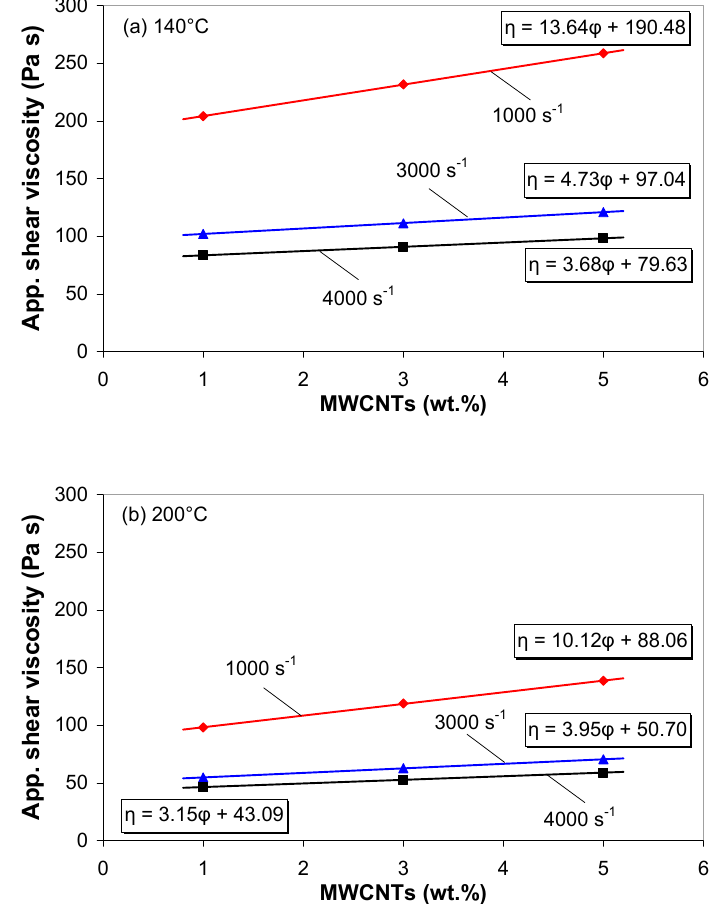
Figure 4. Variation of apparent shear viscosity as a function of MWCNT wt.% at ( a ) 140 °C and ( b ) 200 °C melt temperatures.